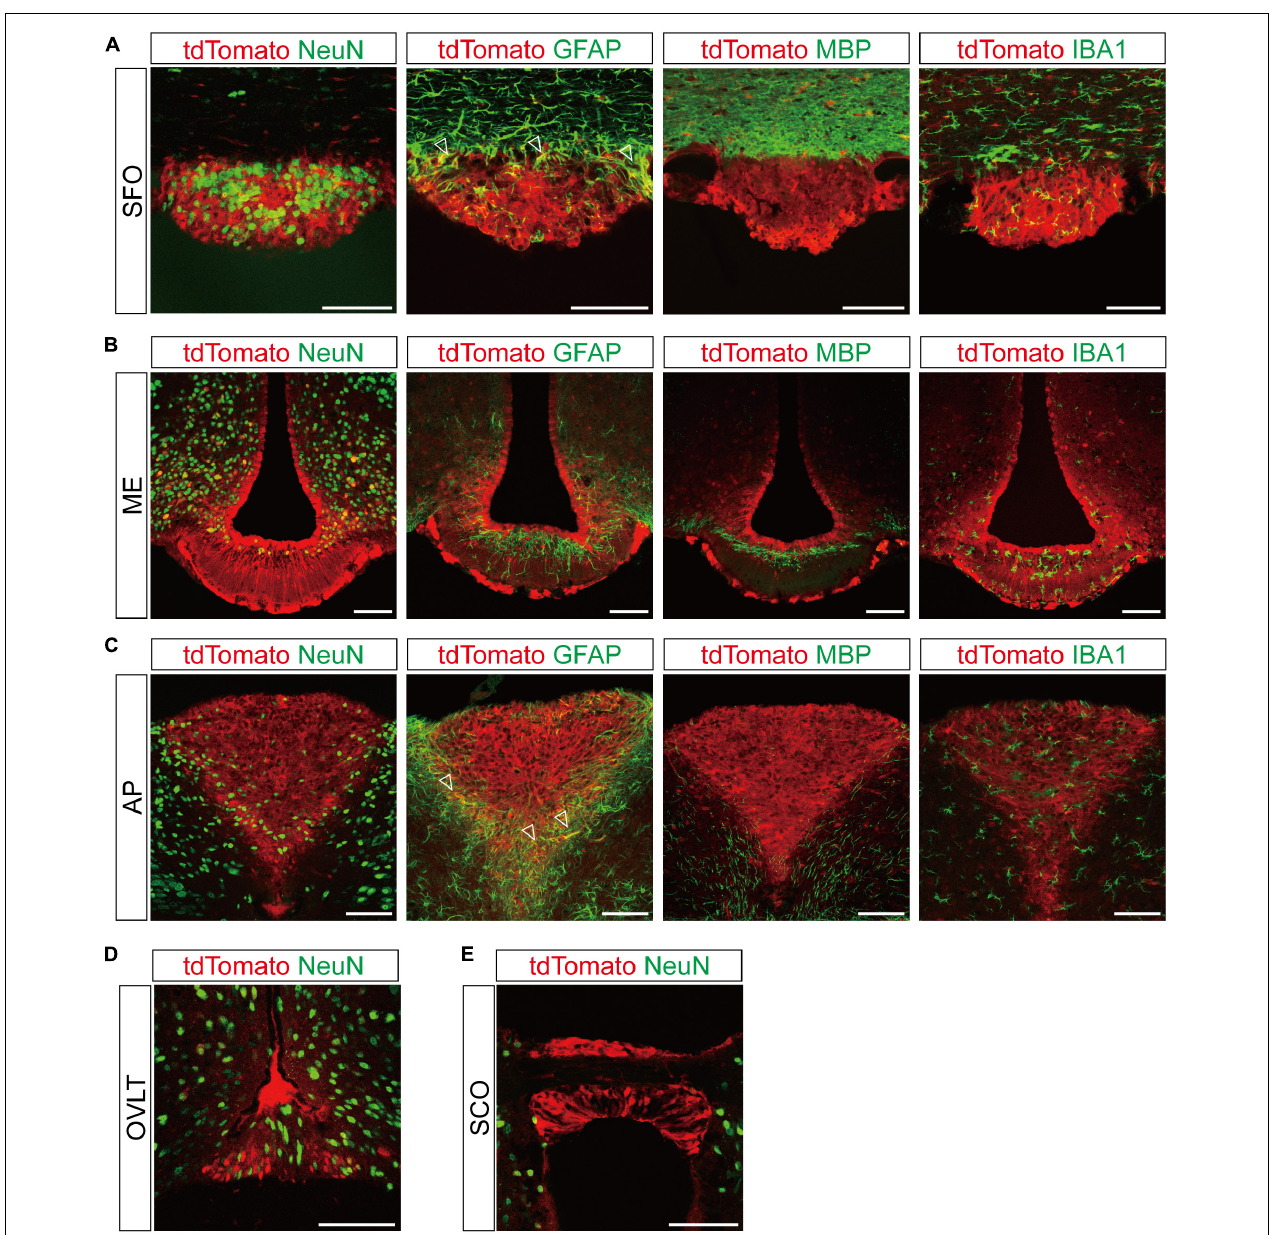
FIGURE 3 | Representative confocal images showing tdTomato fluorescence in the circumventricular organs (CVOs) of T1r2 -tdTomato mice. (A) Subfornical organ (SFO), (B) median eminence (ME), (C) area postrema (AP), (D) organum vasculosum lamina terminalis (OVLT), and (E) subcommissural organ (SCO). Representative markers for neurons (neuronal nuclei, NeuN), astrocytes (glial fibrillary acidic protein, GFAP), oligodendrocytes (myelin basic protein, MBP), and microglia (ionized calcium-binding adaptor molecule, IBA1) are indicated in green; tdTomato is indicated in red. White triangles indicate the overlap of the green and red signals. Scale bar, 100 µ